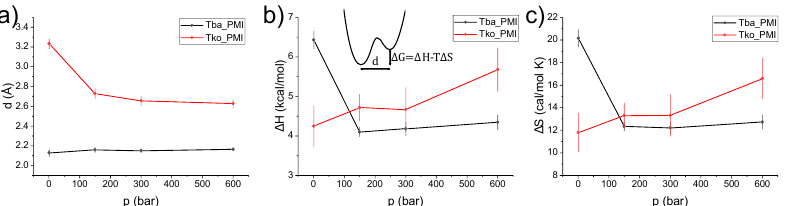
Figure 5. Temperature-independent parameters extracted from the two-state model as a function of pressure for Tba PMI (black symbols) and Tko PMI (red symbols): distance between the two wells ( d , ( a )), enthalpy ( ∆ H , ( b )) and entropy ( ∆ S , ( c )) difference, lines are a guide to the eye. ( b ) also contains a pictorial representation of the model showing how the different parameters influence the shape of a proteins’ energy